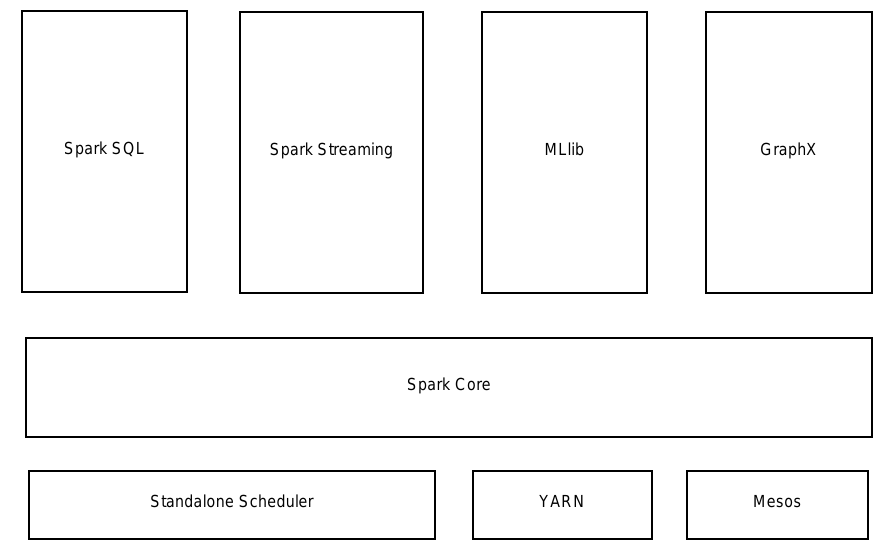
Figure 2. The Spark stack.